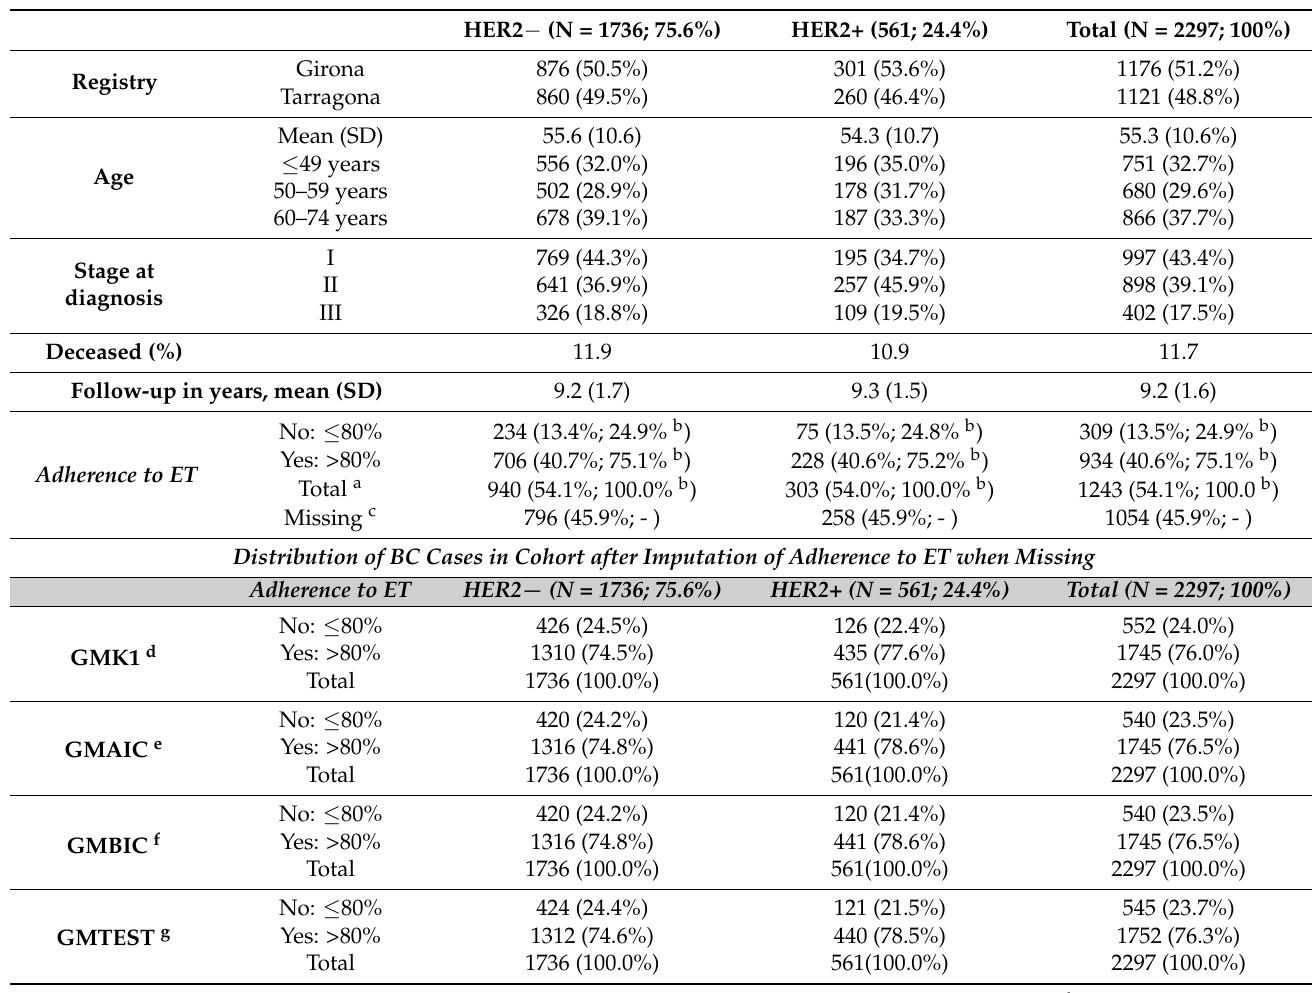
Table 1. Characteristics of patients diagnosed with breast cancer from 2005 to 2009 in Girona and Tarragona. Of the 2297 BC patients, complete data for endocrine treatment ( ET ) were available for 1243 in 2007–2009. Imputation of adherence through ModGraProDep was performed for the remaining 1054 BC